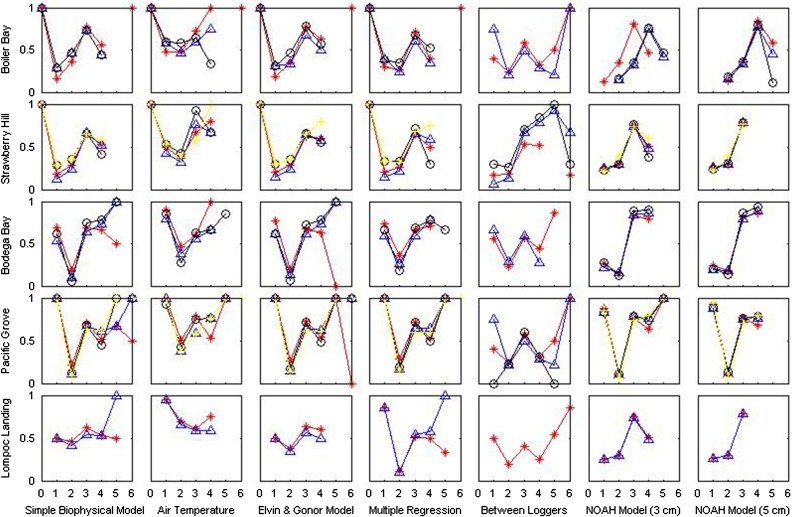
False-alarm ratios for all models at all sites. Category labels are as in Fig. 3.